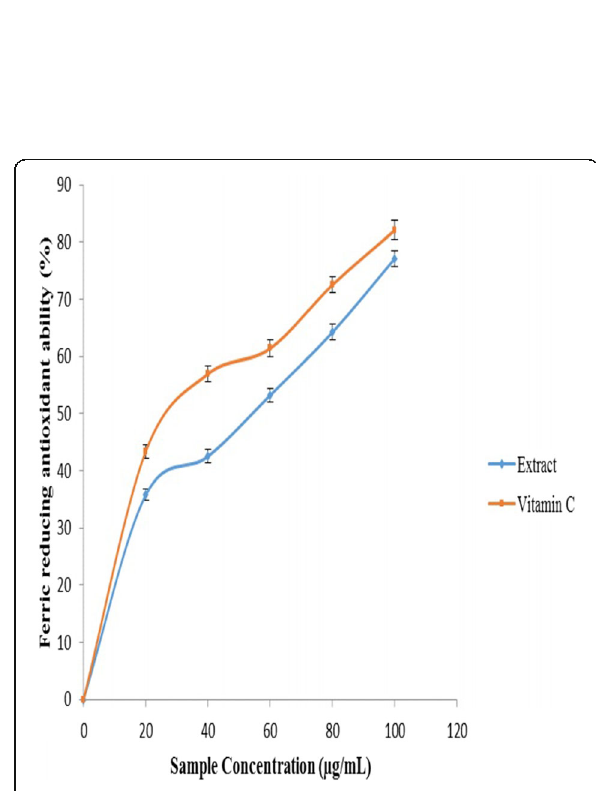
Fig. 6 Ferric reducing antioxidant property (FRAP) of aqueous extract of O. gratissimum leaves and vitamin